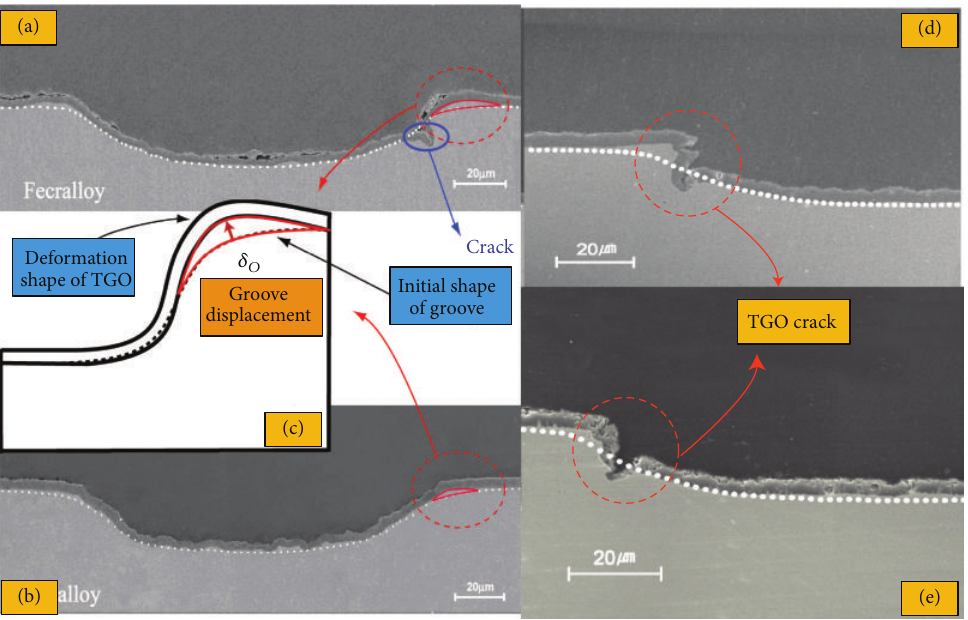
Figure 2: TGO crack and deformation shape near a surface groove.